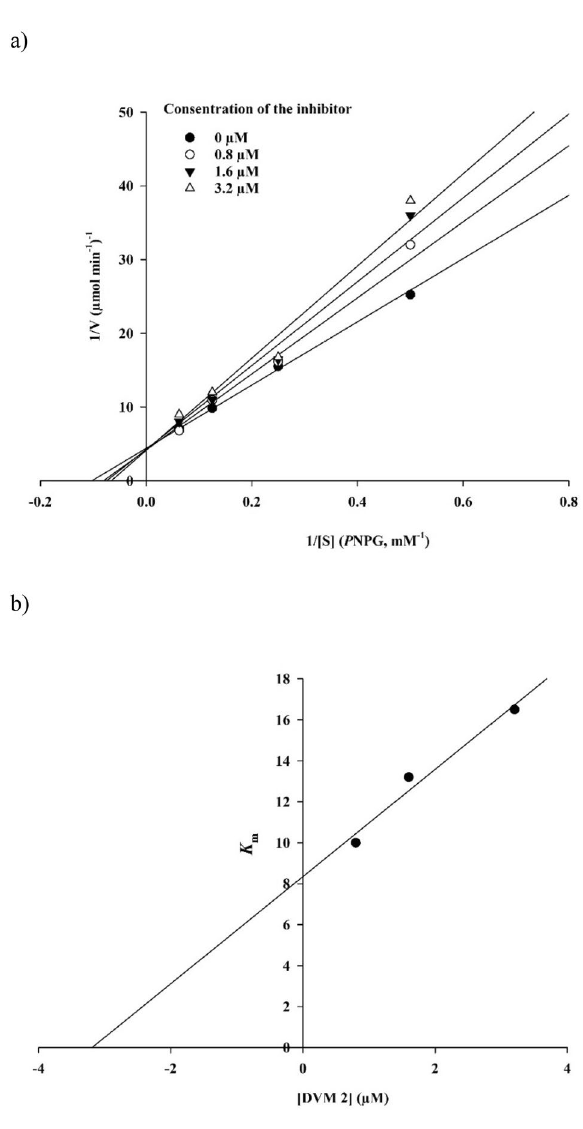
Figure 4. Kinetics of α-glucosidase inhibition by 9d . ( a ) The Lineweaver–Burk plot in the absence and presence of different concentrations of 9d ; ( b ) the secondary plot between K m and various concentrations of 9d